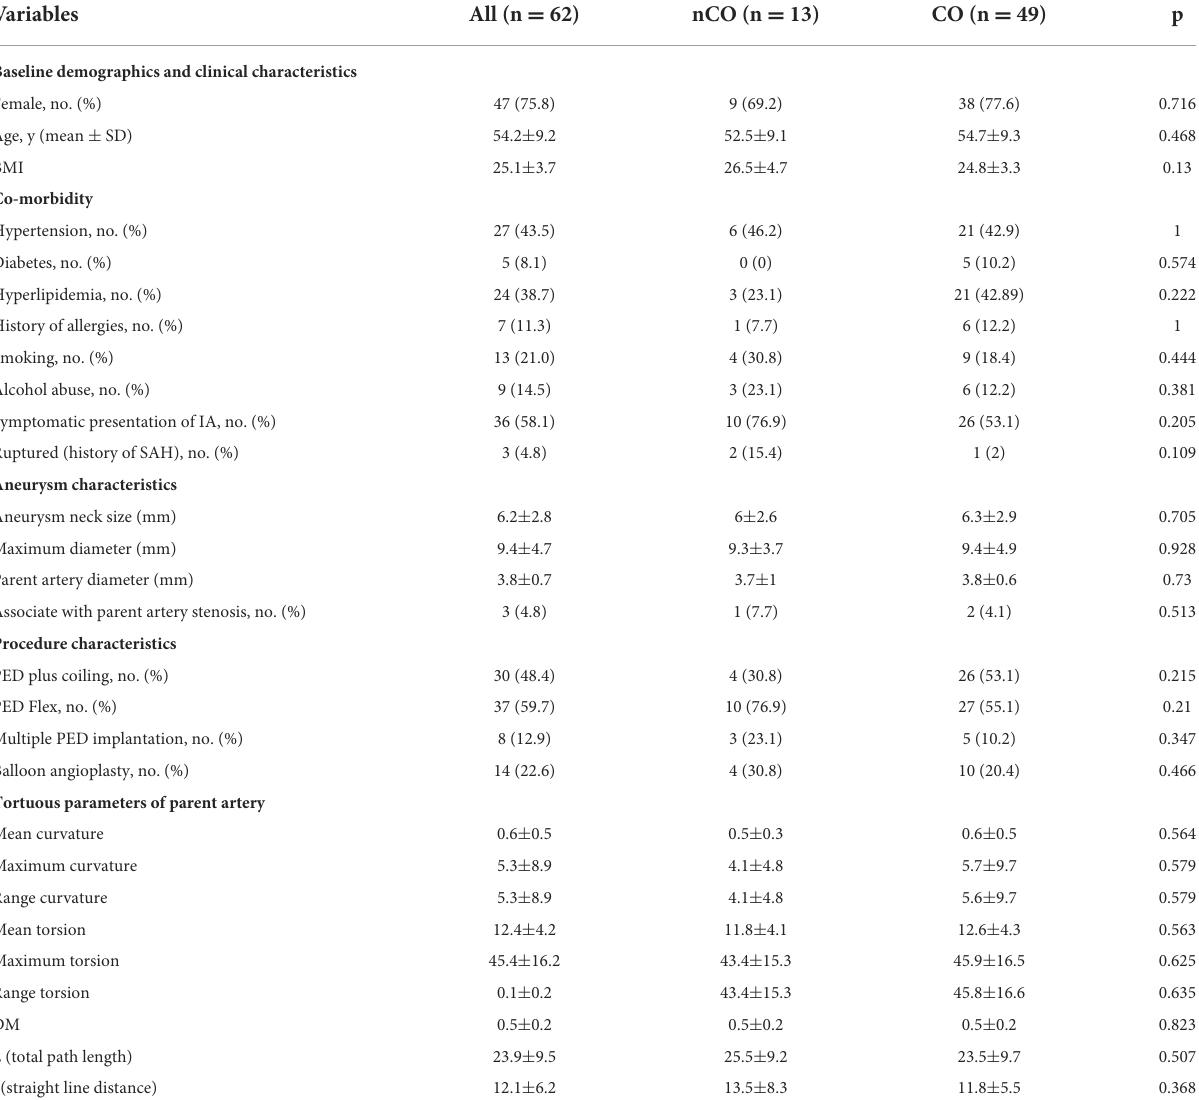
TABLE 1 Univariate analysis in association with CO of